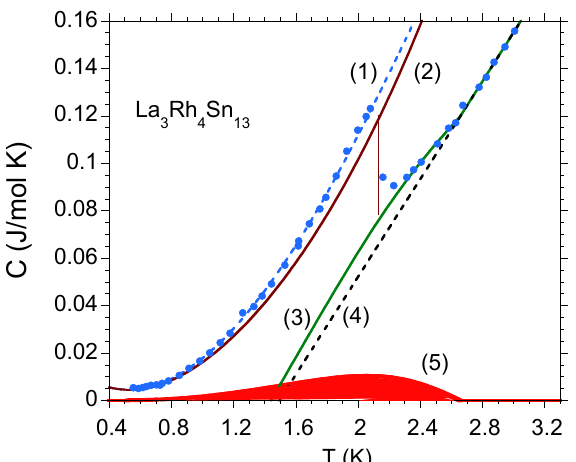
Figure 2. Specific heat C ( T ) for La 3 Rh 4 Sn 13 was approximated using the atomic-scale disorder model. C i represents various contributions to C ( T ) , i = 1 − 5. The blue points are the C experimental data that are well fitted by the expression C 1 ( T ) = γ 0 T + β T 3 + A exp [ − ∆ ( 0 ) / k B T ] with the electronic specific heat coefficient γ 0 = 6 mJ/mol K 2 , lattice contribution with β = 6.5 mJ/mol K 4 , and energy gap ∆ ( 0 ) = 4.2 K at T = 0. C 5 represents the best fit of the Gausian gap distribution f ( ∆ ) with ∆ = 2.06 K and D = 0.25 K 2 . C ( T ) = γ 0 0 T is the electronic contribution to the specific heat. The curve 4 C 3 = C 4 + C 5 , C 2 (red line) was obtained after subtracting the inhomogeneous contribution C 5 from the experimental data.